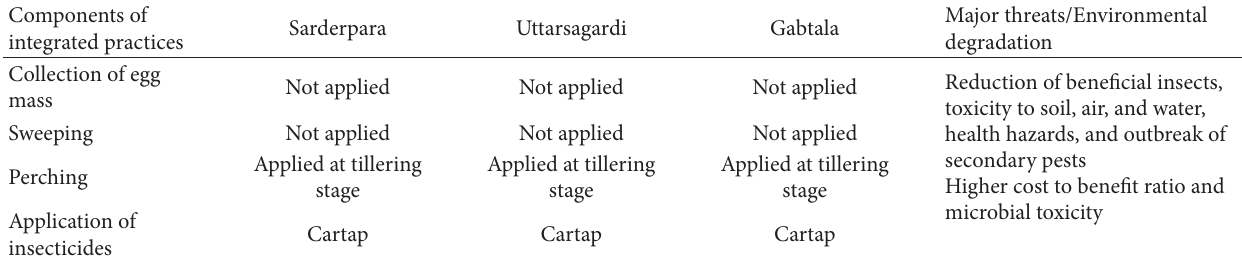
Table 3: Record of farmers’ practices in the rice ecosystem in